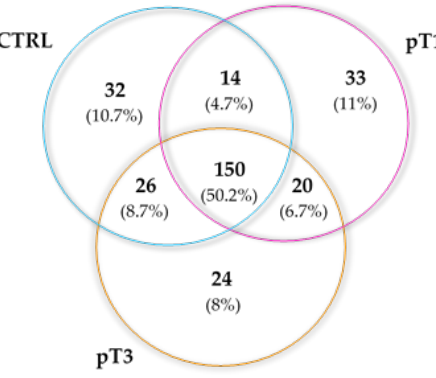
Figure 2. Distribution of the urine N -glycoproteins identified by shotgun LC-MS illustrated by a Venn diagram.